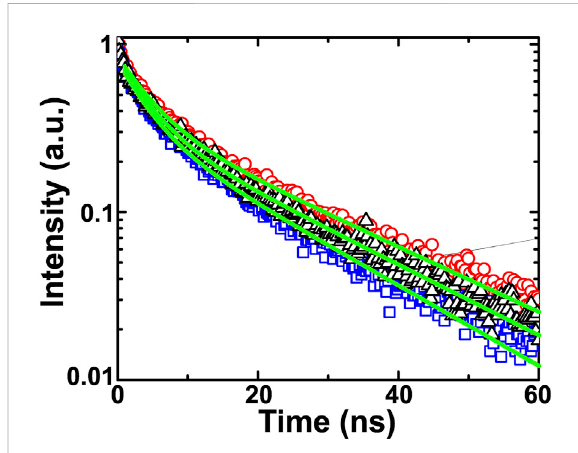
The emission decay of the reference sample (triangles) and sample B sample measured in rear-side (circles) and front-side (squares) geometry. The solid lines are the biexponential fi t to the respective decay